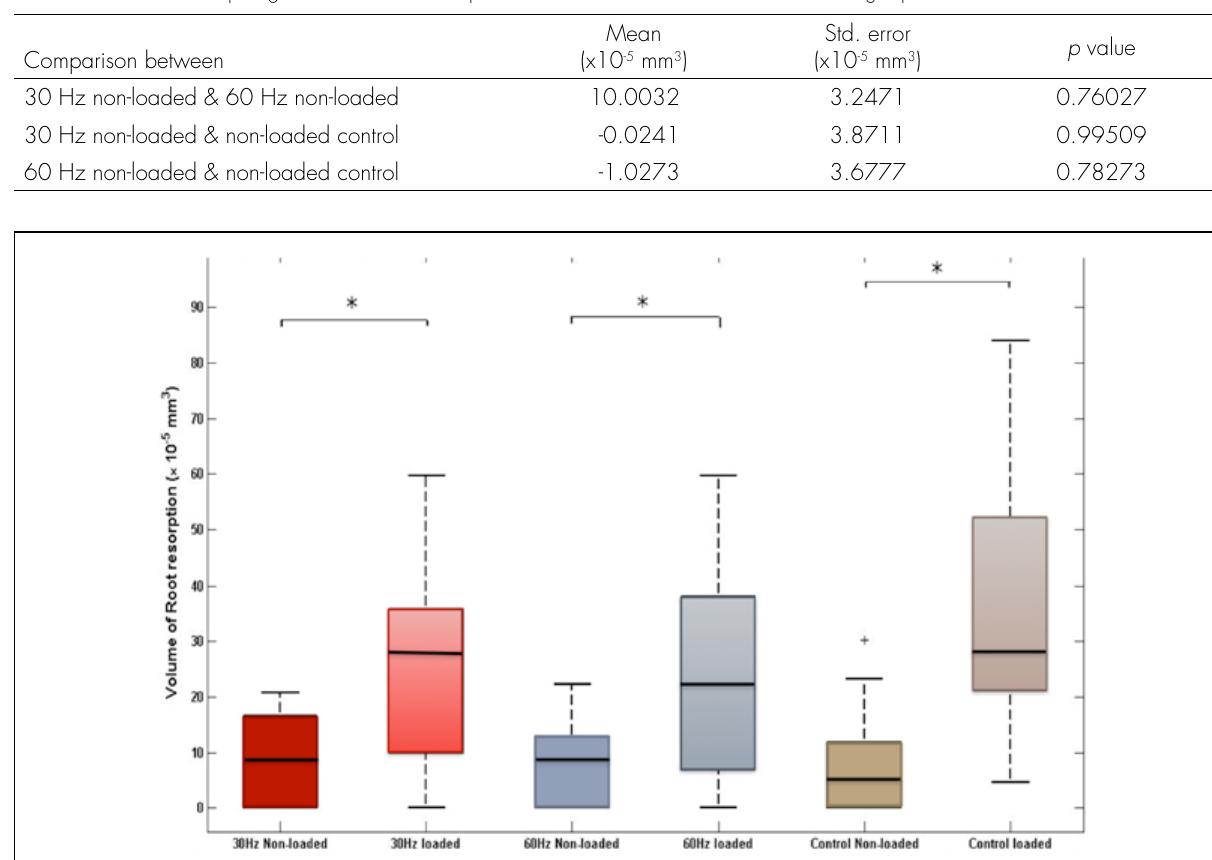
Table III. Student t -test comparing the volume of root resorption crater in unloaded molars between vibration